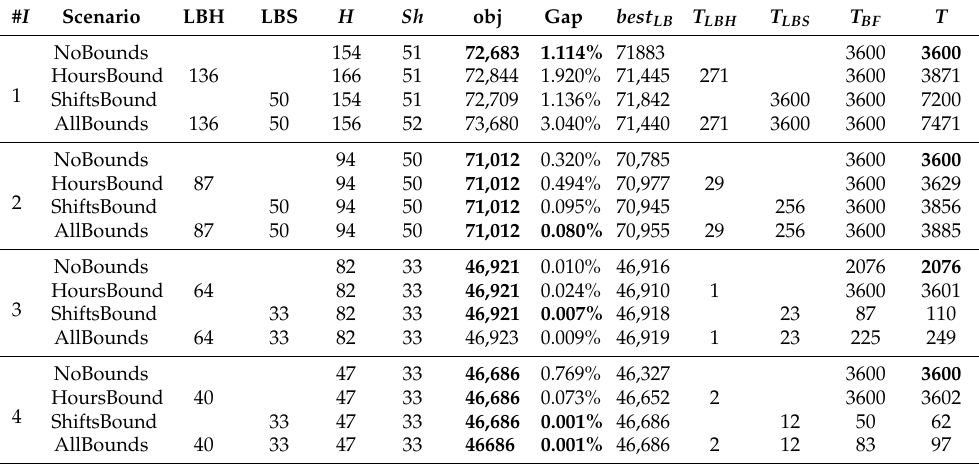
Table 9. Solution quality and execution time for the 16 considered problem instances using the four proposed bound scheme